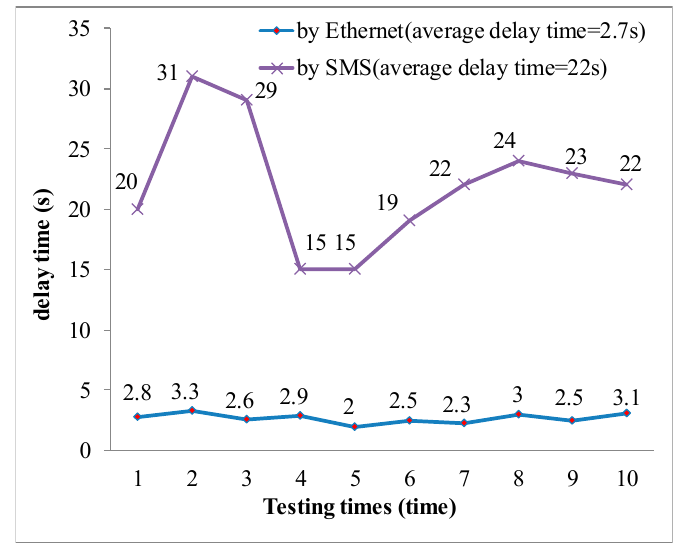
Figure 19. The testing results of communicating delay time over Ethernet an SMS.